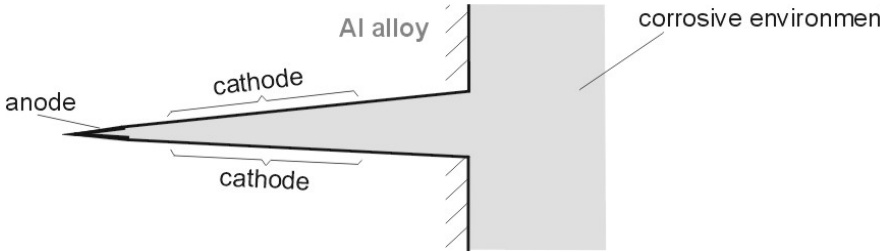
Figure 20. Corrosion cell originating in a crack after mechanical pitting of a crack.